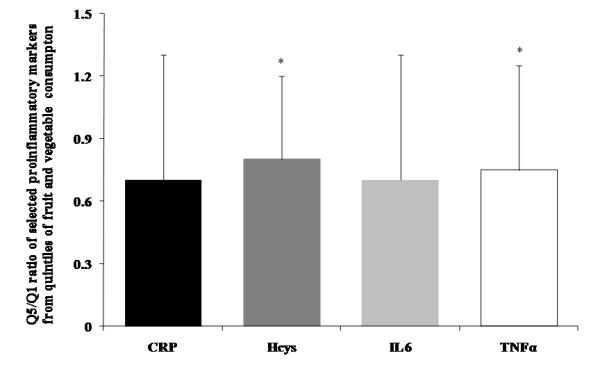
Ratios of protein levels of selected proinflammatory markers, calculated from the fifth quintile (Q5: > 1150 g/d; n = 24), as compared to the first quintile (Q1: < 380 g/d; n = 24) of energy-adjusted fruit and vegetable consumption. *P < 0.05, Q1 vs. Q5, from post hoc Tukey test to correct for multiple comparisons, after performing ANOVA one-factor test (n = 120). CRP, C-reactive protein; Hcys, homocysteine; IL6, interleukin-6; TNFα, tumor necrosis factor-alpha